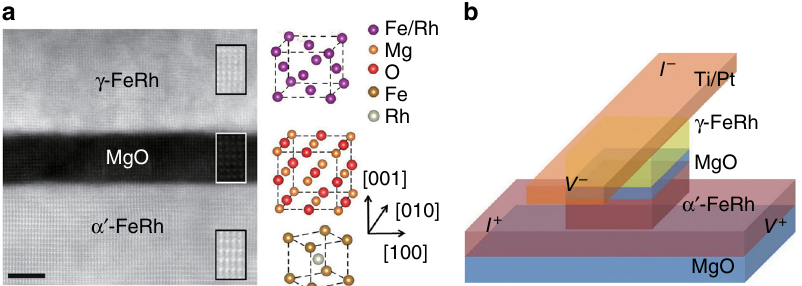
Fig. 1 Microstructure and measurement geometry of α ′ -FeRh/MgO/ γ -FeRh junctions. a Cross-sectional Z -contrast STEM image of the stack fi lms and the schematic of crystal lattice of α ′ -FeRh, MgO, and γ -FeRh. Scale bar is 2 nm in length. b A schematic of sample layout and the geometry for four-terminal